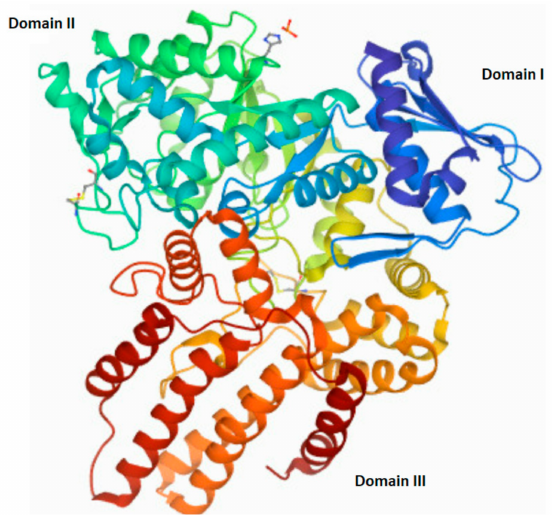
Figure 4. The tertiary structure of human N -acetyl-alpha-glucosaminidase (EC 3.2.1.50). A modified image from the RCSB PDB (rcsb.org) of PDB ID 4XWH_1